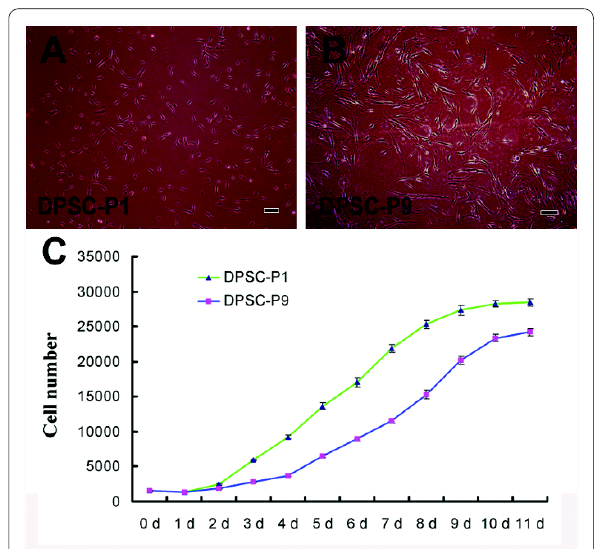
Figure 1 Morphological appearance and growth curve of DPSCs at different passages . ( A ) DPSCs at the 1 st passage. ( B ) DPSCs at the 9 th passage. Many DPSCs became enlarged and elongated with one or two cellular processes. ( C ) Growth curve of DPSCs at the 1 st and 9 th pas- sages. Population doubling time (PDT) in DPSC-P1 and DPSC-P9 group was 1.83 d and 3.42 d respectively. Values are mean ± s.d., n = 3. Scale bars: 50